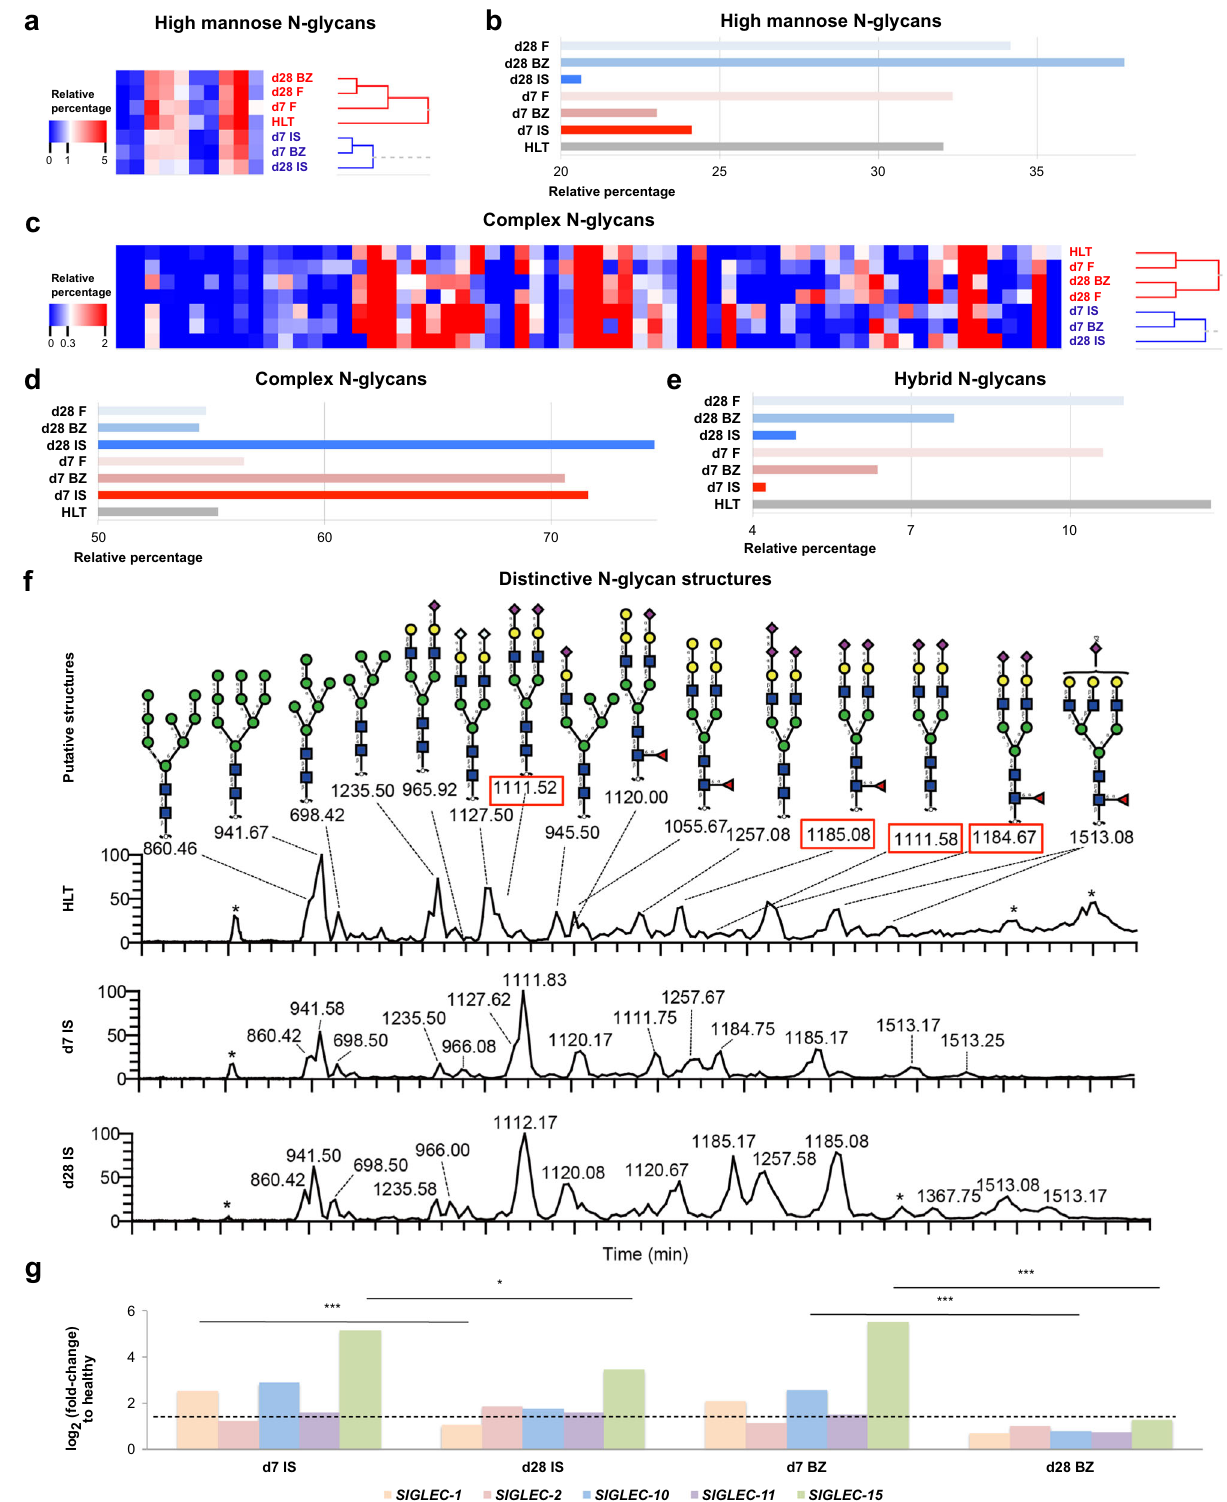
(Fig. 4g). In addition, SIGLEC − 15 expression was signi fi cantly increased both in the ischaemic core ( P <0.05) and border zone ( P < 0.001) region, and SIGLEC − 10, another marker of in fi ltrating activated monocytes and macrophages 42 , decreased ( P <0.001) from d7 to